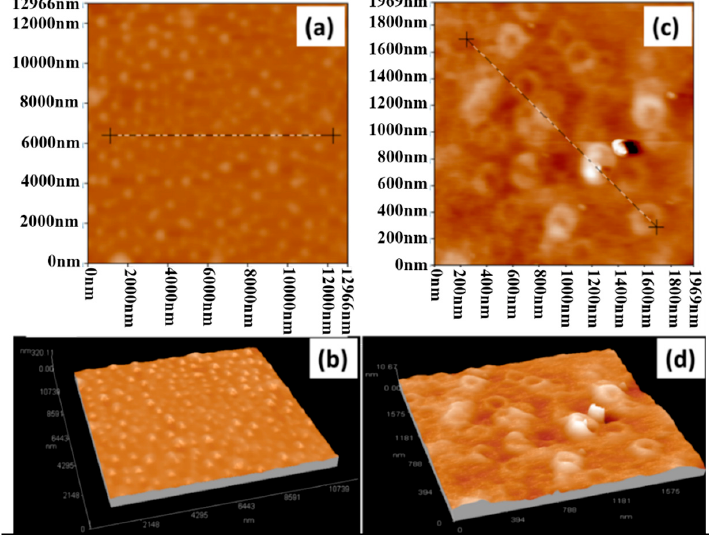
Figure 9. AFM Surface and 3D micrographs of silicon wafer coated with PAA ( a , b ) and with PAA/PDDA/ZrP ( c , d ).